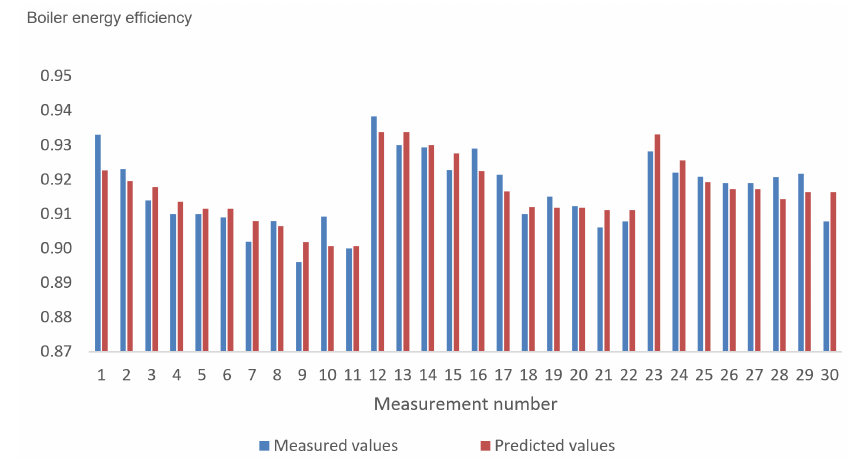
Figure 2. Comparison of the predicted values of the boiler energy efficiency model with measured values. Table 2. Residual standard